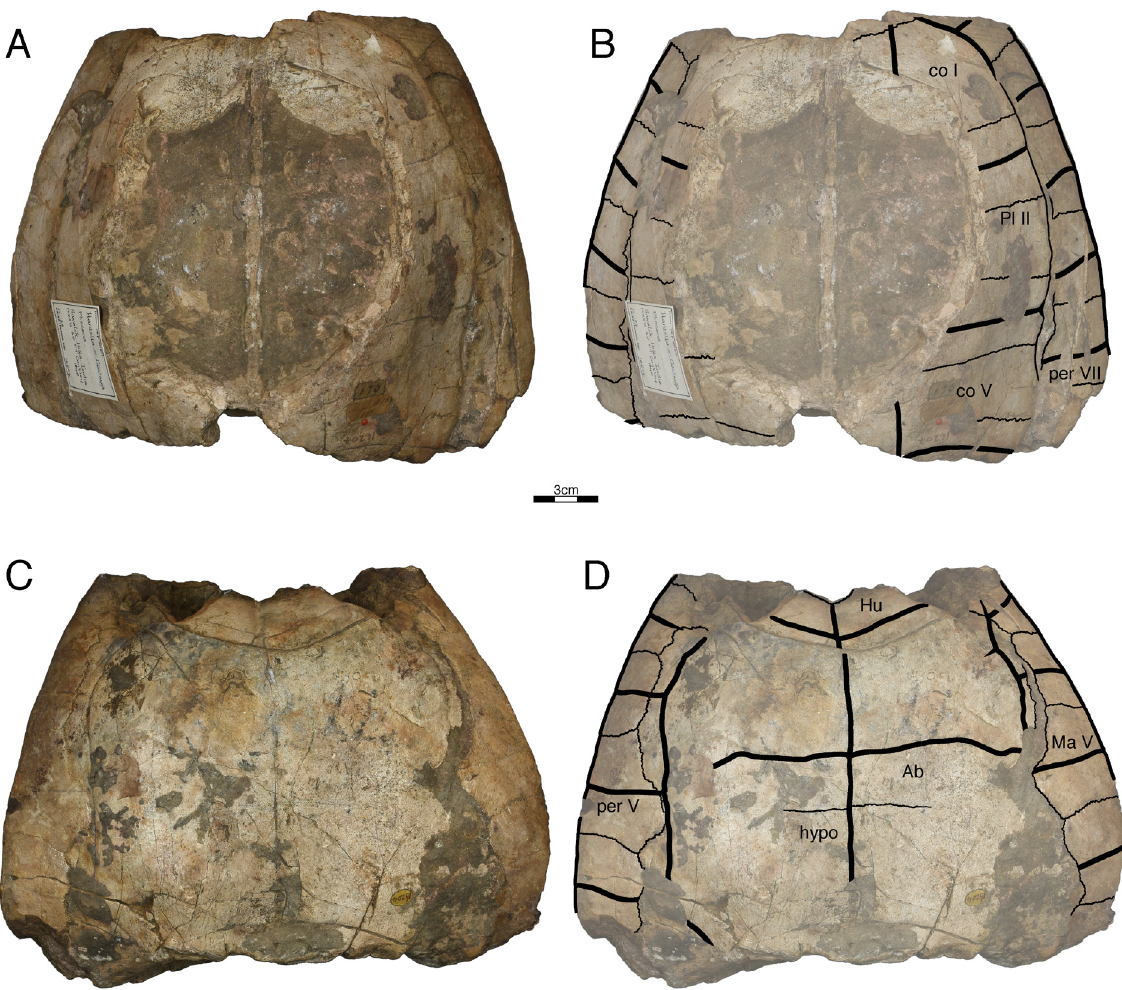
Fig. 8. BMNH 16204, referred to Hardella thurgi (Gray, 1831) by Lydekker (1889b), here identified as Palatochelydia indet. A . Photograph of carapace. B . Illustration of carapace. C . Photograph of plastron. D . Illustration of plastron. Scale bar: 3